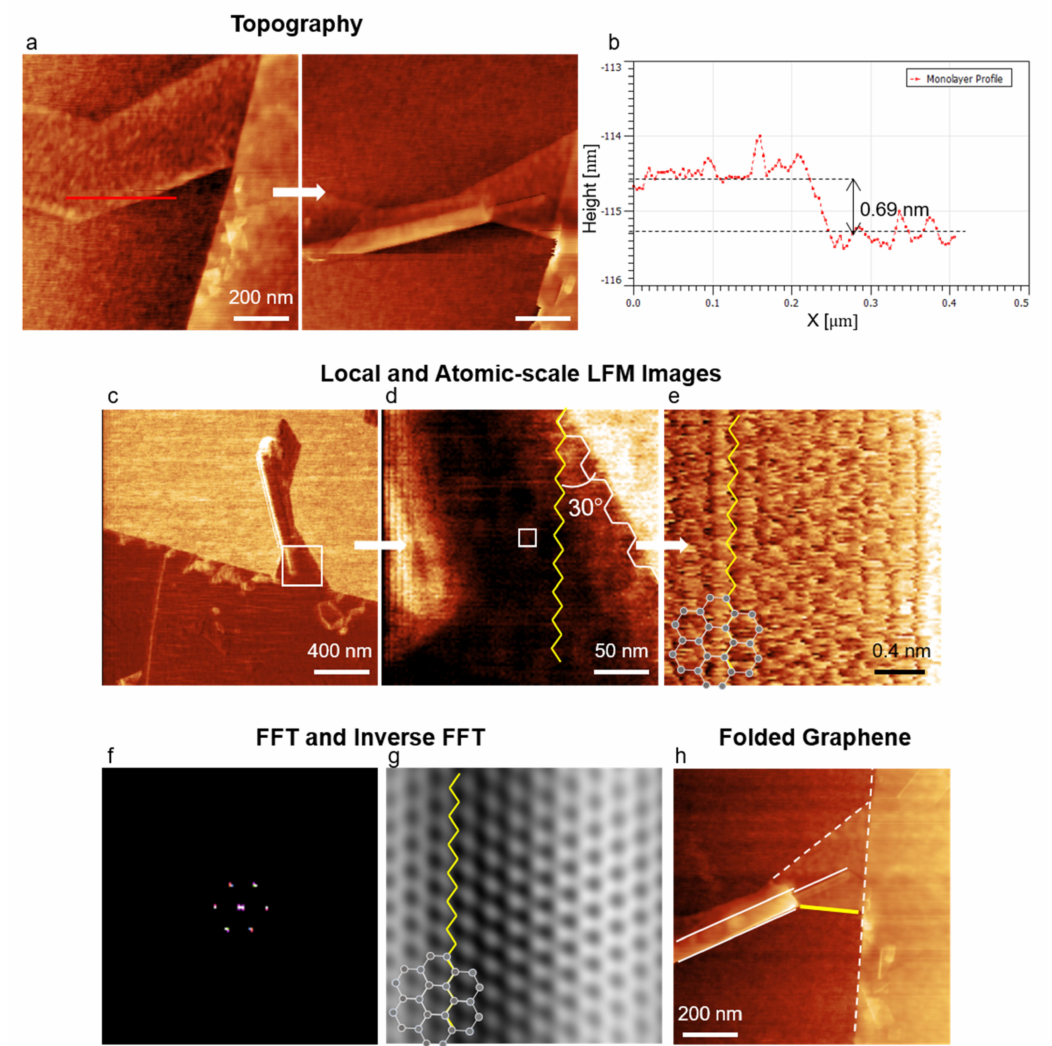
Figure 9. The edges of self-folded graphene nanostructure. ( a ) Topographies of graphene before and after the AFM-induced self-folding; ( b ) cross-sectional profile along the red line in ( a ); ( c ) LFM image of the folded graphene; ( d ) LFM image taken from the squared area in ( c ); ( e ) atomic-scale image collected from the white square in ( d ); ( f ) filtered FFT image of ( e ); ( g ) inverse FFT image of ( e ); ( h ) topography of the folded graphene. The white-solid (yellow-solid) line corresponds to the edge folded along the armchair (zigzag) direction. The white-dotted line is the edge torn along the armchair direction during mechanical ex-foliation. The white hexagons in ( e , g ) are for visual